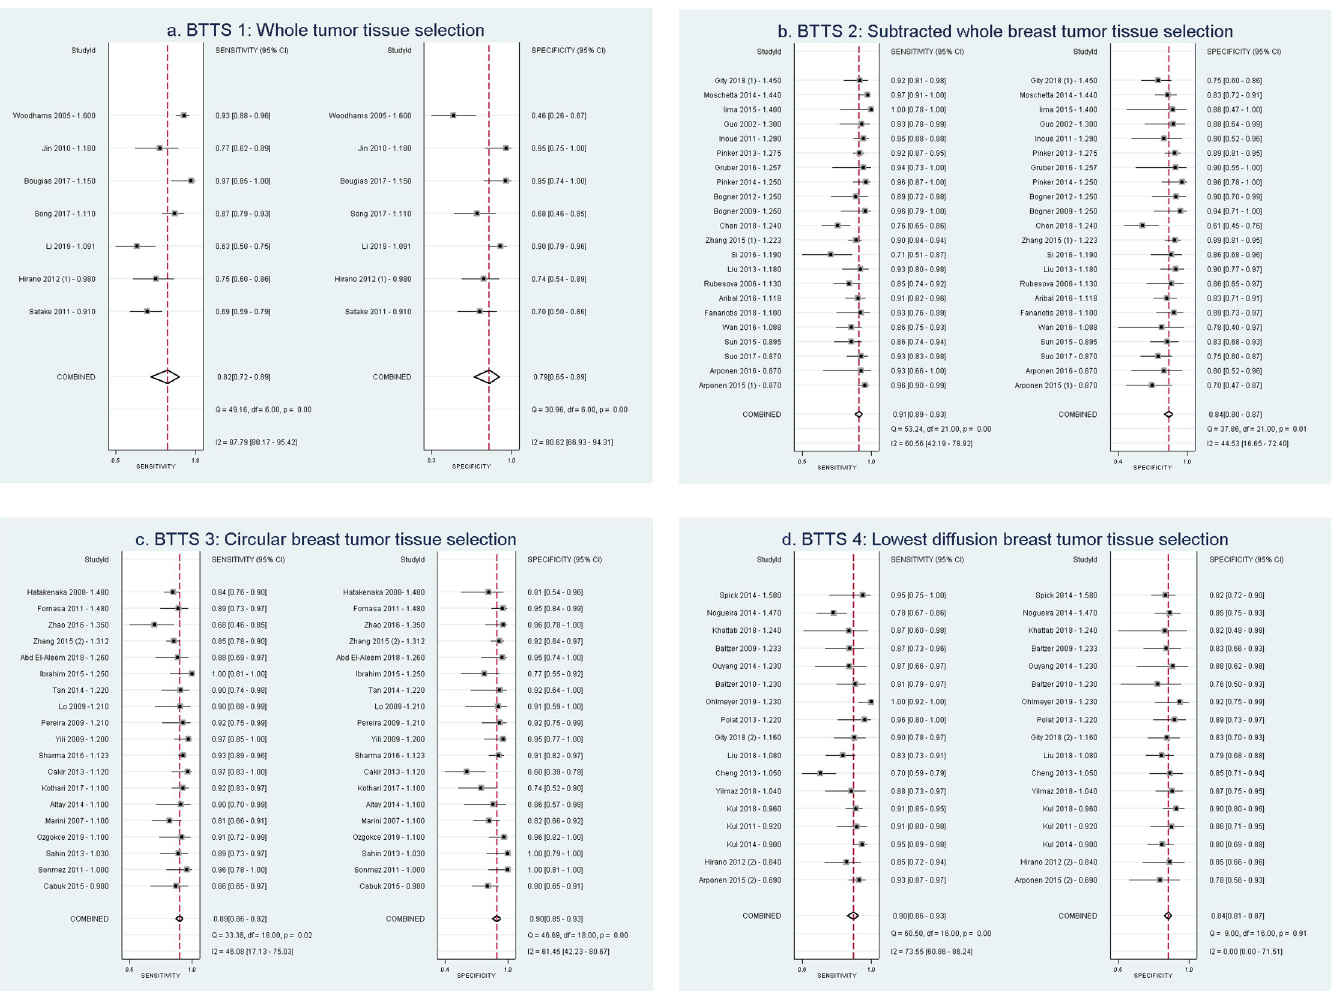
Fig 2. Forest plots for each BTTS method, showing sensitivity and specificity with confidence intervals of each study subset and in the last row the pooled values (diamond). Study subsets are sorted by ADC threshold. Study ID = Author—ADC threshold (10–3 mm2/s). a) BTTS1: Whole breast tumor tissue selection, b) BTTS2: Subtracted whole breast tumor tissue selection, c) BTTS3: Circular breast tumor tissue selection, d) BTTS4: Lowest diffusion breast tissue selection. BTTS = breast tumor tissue selection. (1)/(2) refers to the two different BTTS method inclusions (study subsets) from the same